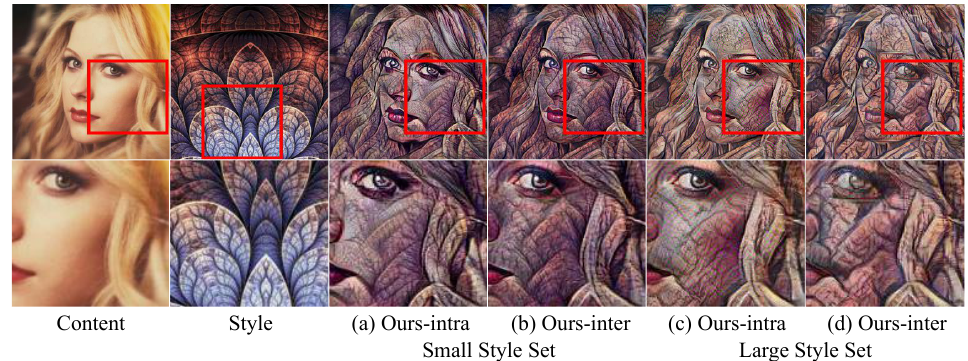
Figure 7. Comparison of intra-scale and inter-scale transform: ( a , b ) The results of networks trained with a small style set. ( c , d ) The results of networks trained with a large style set. (first row) Original images. (second row) The red box regions of the first row images.